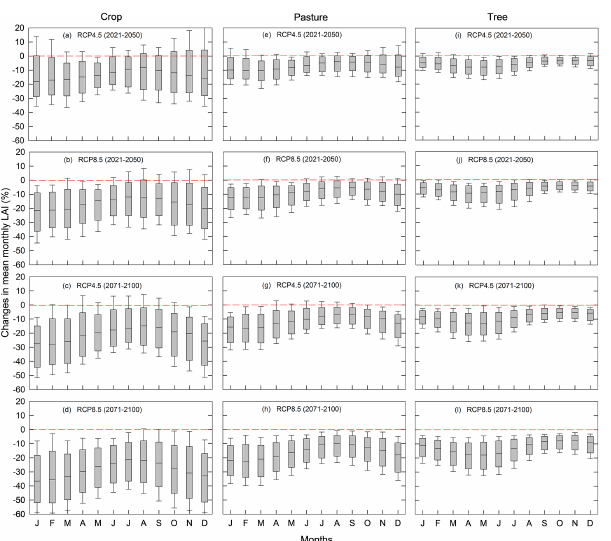
Figure 5. Box plots of changes in mean monthly LAI derived from the 38 CMIP5 runs for climate projections during 2021–2050 and 2071–2100 under RCP4.5 and RCP8.5 scenarios for crop (a, b, c, d) , pasture (e, f, g, h) and trees (i, j, k, l) in the Goulburn–Broken catchment. Changes are relative to LAI calculated using climate time series for the 1981–2010 baseline. The lower boundary of the box indicates the 25th percentile, a line within the box marks the median, the upper boundary of the box indicates the 75th percentile and the whiskers are delimited by the maximum and minimum.